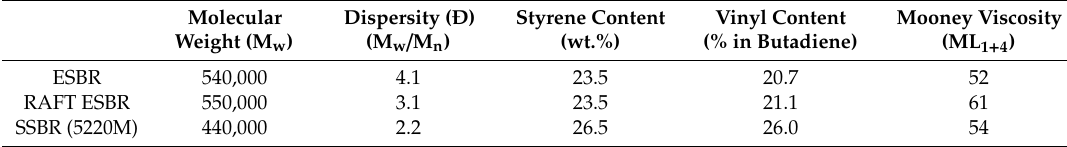
Table 5. Characteristics of emulsion styrene butadiene rubber (ESBR) and reversible addition-fragmentation radical transfer ESBR (RAFT